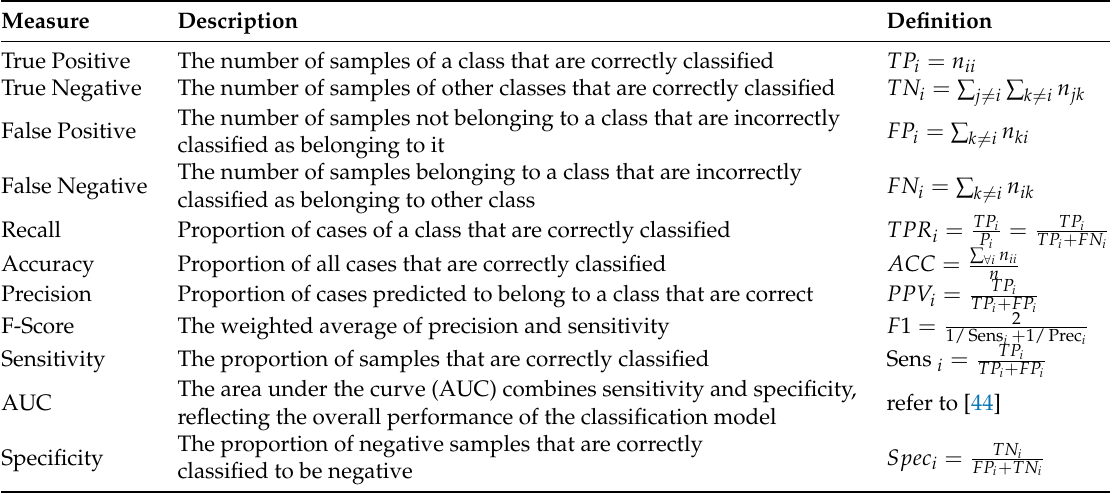
Table 3. Statistic information of prediction